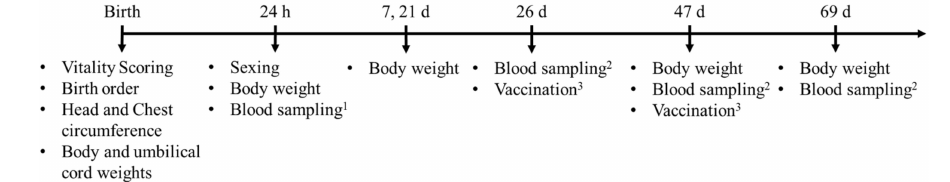
Figure 1. Timeline of the study procedures performed during preweaning and postweaning periods. Blood samples for determination of serum IgG 1 and PCV-2 2 antibodies titer. h: hours of life; d: days of life. 3 Vaccination against PCV-2. Clinical inspection was performed daily throughout the study